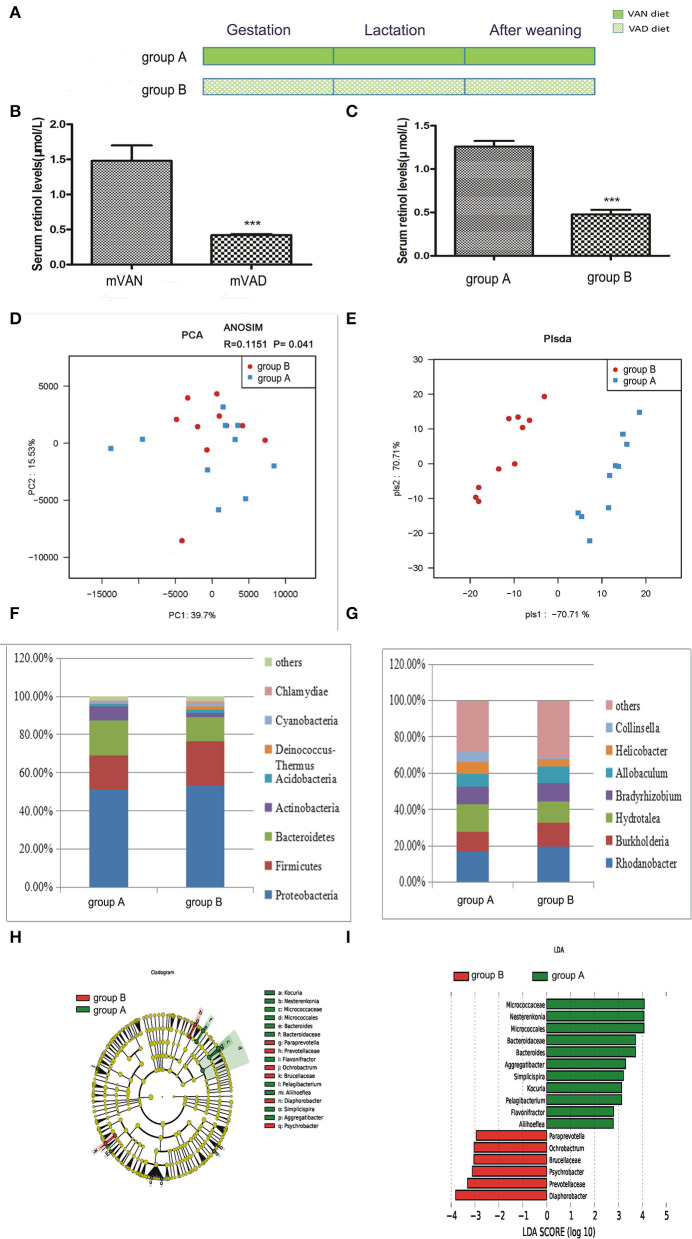
The comparison of colonic mucosal microbiota between the group A and group B. (A) Schematic diagram showing the two offspring groups: group A, group B. The group A pups were delivered and nursed by maternal VAN rats and then fed a VAN diet for 3 wk after weaning. The group B pups were birthed and nursed by maternal VAD rats and fed a VAD diet for 3 wk after weaning. (B) The serum retinal levels of the maternal rats. Serum VA levels were detected by HPLC. Values represent mean ± SD n = 10 mVAN and 10 mVAD, ***P < 0.001 by Student's t-test. mVAN refers to the maternal rats with VAN diet; mVAD refers to the maternal rats with VAD diet. (C) The serum retinal levels of offspring at 6 weeks old. Serum VA levels were detected by HPLC. Values represent mean ± SD n = 10 group A and 10 group B, ***P < 0.001 by Student's t-test. (D,E) The PCA and PLS-DA analysis of the samples between the group A and group B. (D) PCA scores were plotted based on the relative abundance of OTUs (n = 10). (E) PLS-DA was plotted based on the unweighted UniFrac distance metrics (n = 10). The red circles represent for the group B, blue squares for the group A. (F) The phylum level of dominant bacteria with relative abundance more than 1% in the two groups. (G) The genus level of dominant bacteria with relative abundance more than 5% in the two groups. (H,I) Different structures of colonic mucosal microbiota in offsprings rats with VAN or VAD diet by LEfSe analysis. (H) A cladogram of the statistical and biological differences in the colonic microbiota between the group A and group B, which are shown by the color of the most abundant phylotypes (red indicating group B, green A, and yellow non-significant) (n = 10). (I) A histogram of the LDA scores for the most abundant phylotypes (n = 10).